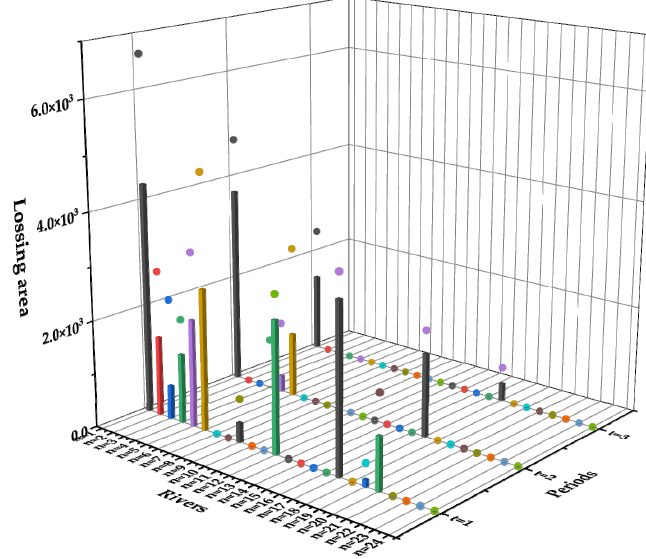
Figure 8. Loss of water ecosystem (river) area (10 4 m 2 ).